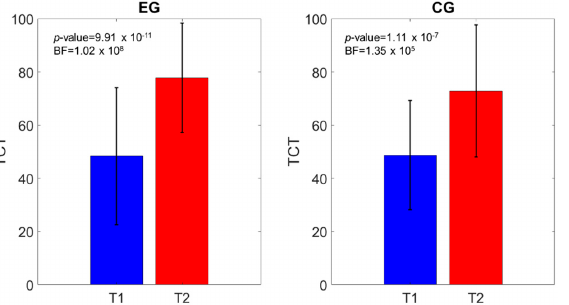
Figure 4. Trunk Control Test (TCT) comparison of the scores at T1 and T2. The p -value and the BF of the intragroup effects are shown.